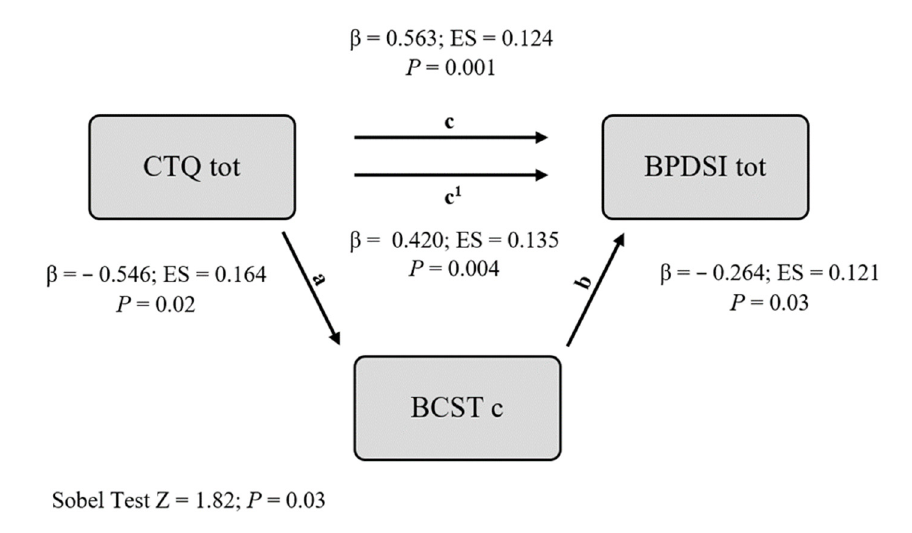
Figure 1. Mediational model (M = BCSTc).